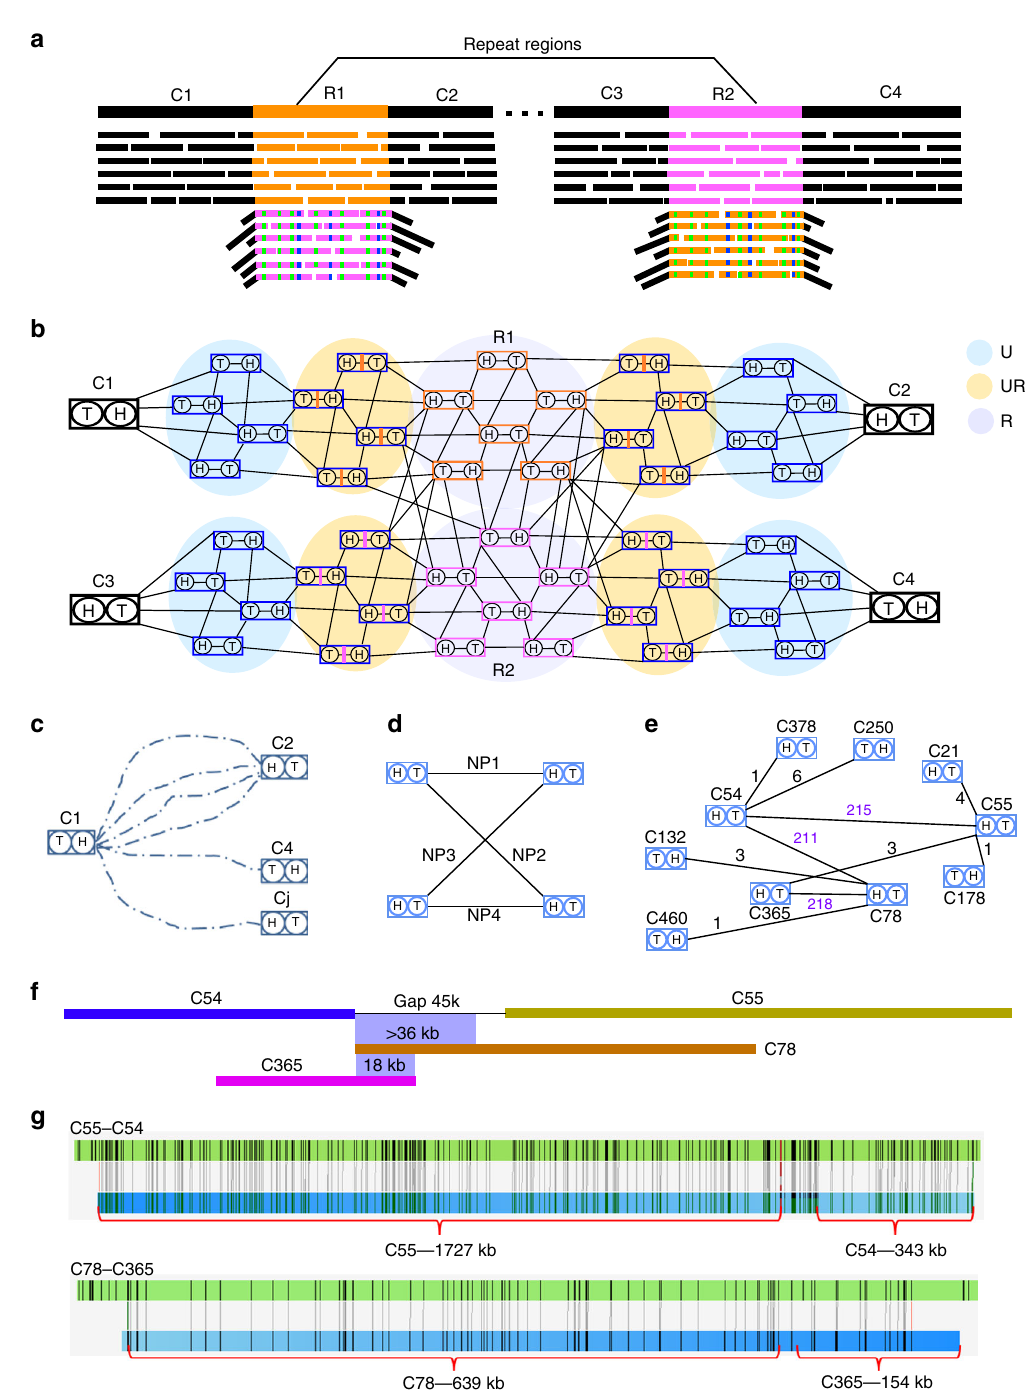
Fig. 1 Overview of HERA. a Two copies of repeats (R1 and R2) are similar to each other but they also contain sequence variations which can be found in the reads originating from them. The alignments of junction reads (across the boundary between repeat and unique sequences) to a different repeat copy form overhangs of unaligned, unique sequences. b A subgraph of an overlap graph corresponding to the genome segments and sequencing reads shown in ( a ). The sequencing reads can be classi fi ed into three types: unique reads (U), repeat reads (R) and junction reads (UR). c The path extension from contig end C 1 h can reach a set of other contig ends, which include C 2 h , the true target, and C 4 t , the false target, and possibly others (C j h ) from background noise. d A connection graph showing the number of paths (NP) between each pair of contig nodes. e A subgraph of a connection graph with examples of con fl icting connections. The con fl icting indices of two contig ends were: CI 54 t = 211/215 = 0.98; CI 78 h = 211/218 = 0.97. These con fl icting connections can be resolved because the number of paths between C 365 t -C 55 h was very small, so that C 78 h -C 365 t can be connected fi rst. f Sequence alignments showing a fragment of at least 36 kb in C 78 being similar to the connecting sequence between C 54 t and C 55 h and 18 kb of highly similar sequence in C 365 t overlapping C 78 h . g The alignments to BioNano genome maps con fi rmed that the connections of C 54 t -C 55 h and C 78 h -C 365 t were correct.